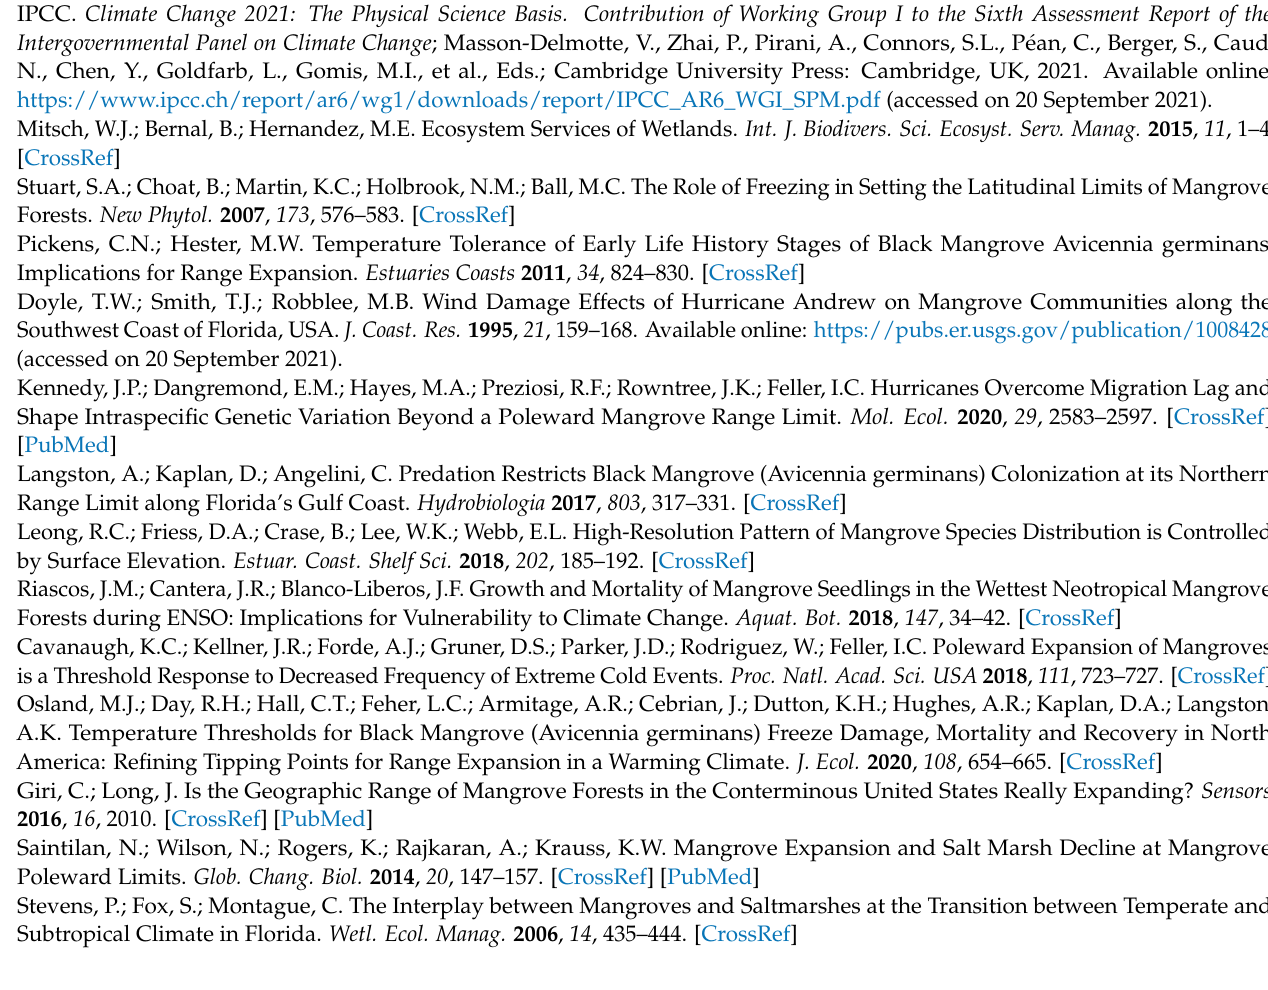
salt marsh, Figure S2: photograph of core collection at Nease Park, Figure S3: photograph of Vilano Boat Launch core showing sampling